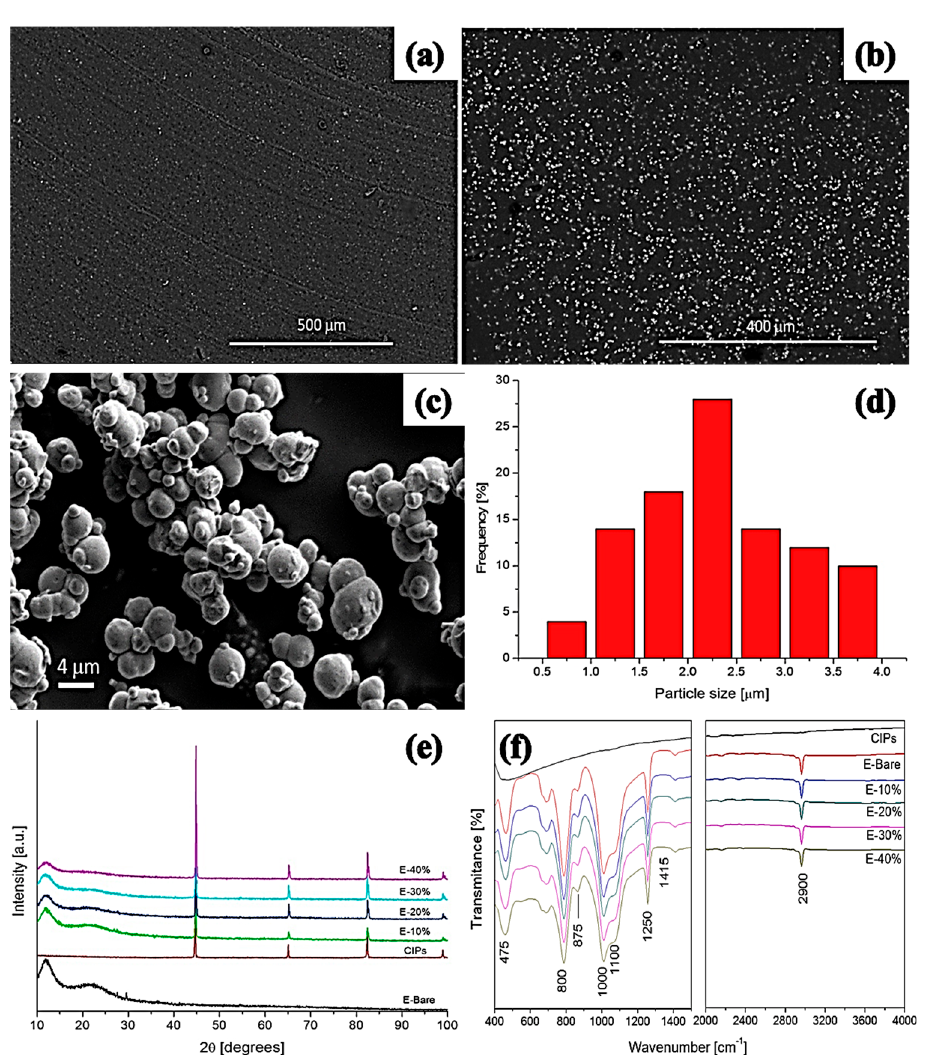
Figure 4. SEM micrographs of ( a ) CIPs-free MRE, ( b ) MRE with 20 wt% CIPs, ( c ) high-magnification micrograph of MRE, ( d ) histogram exhibiting CIPs size distribution in MREs, ( e ) XRD spectra, and ( f ) FTIR spectra of MREs [23] (reprinted with permission from Elsevier TM ).